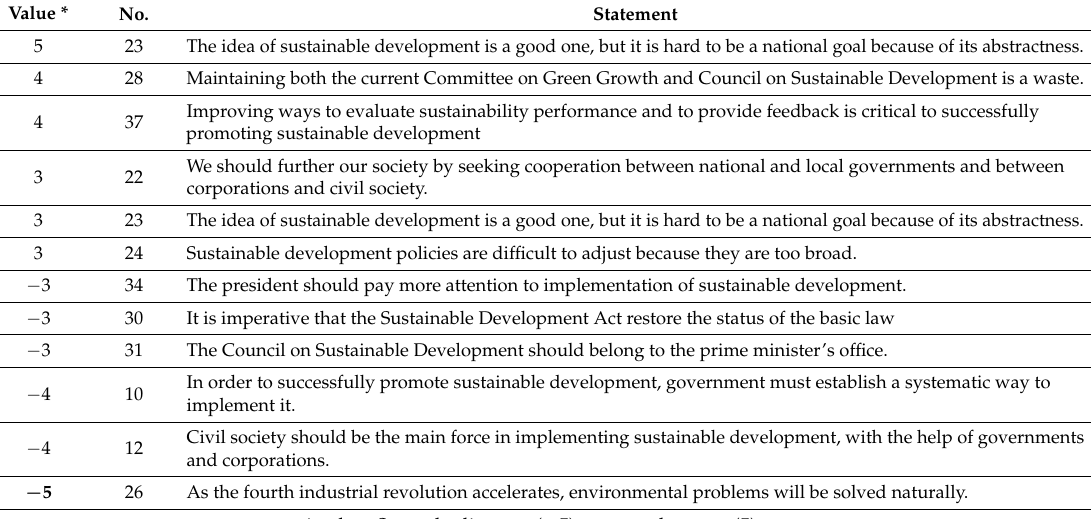
Table 9. Skeptics’ Q